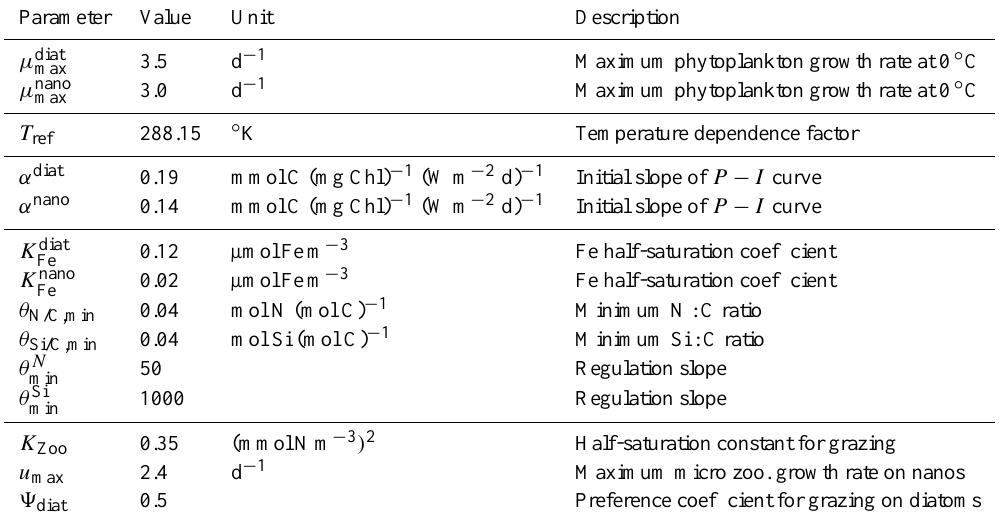
Table A8. REcoM2